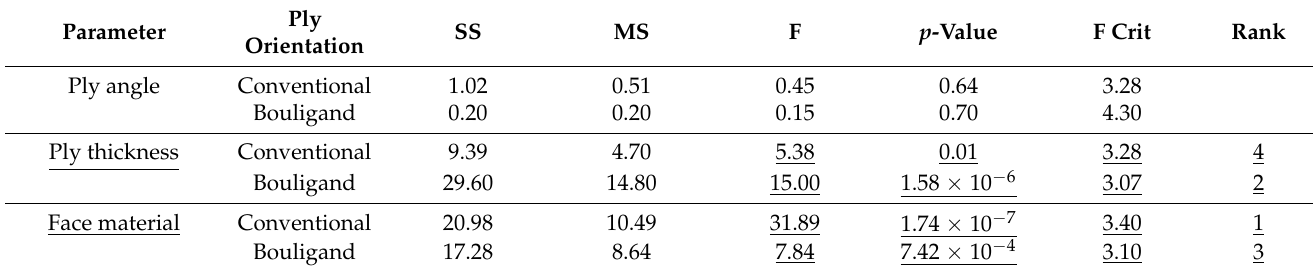
Table A3. FRP arrangement SSF. Statistically significant parameters are underlined.